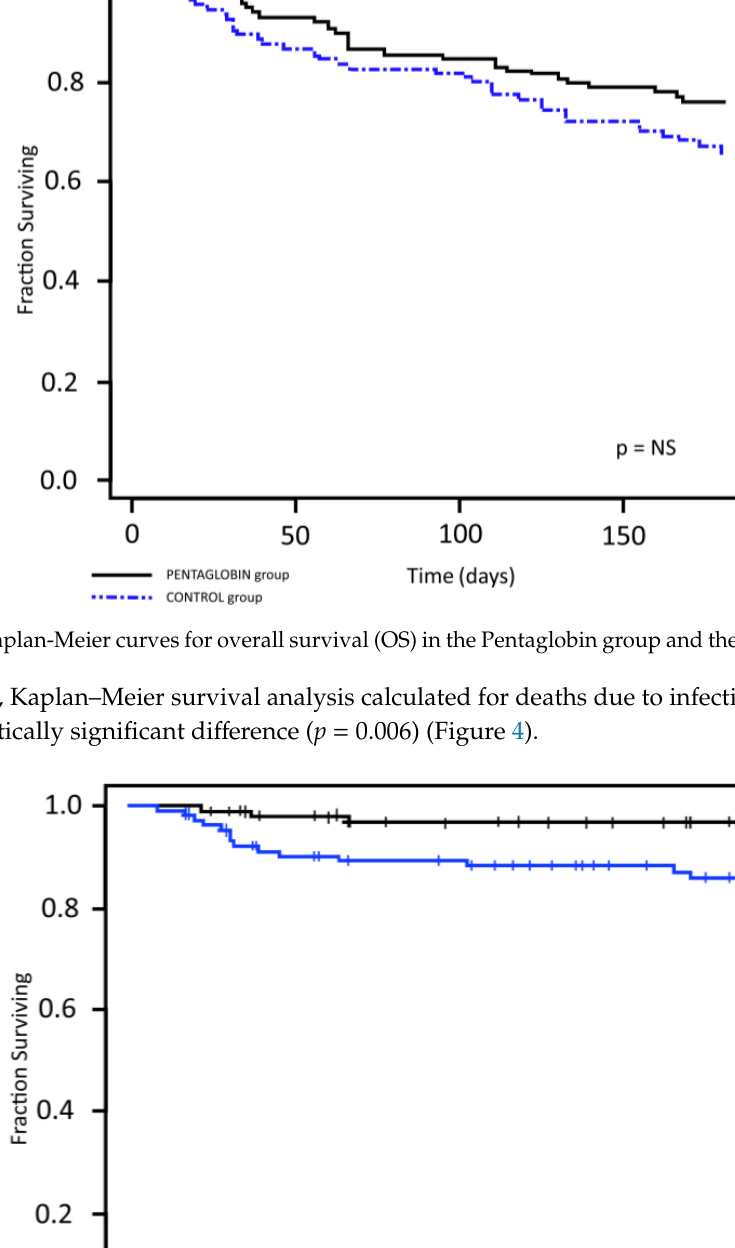
Figure 5. Kaplan–Meier survival curves in two groups calculated for deaths, excluding mucositis and enteritis. 3.3. Secondary Outcomes Box-plot analysis showed a statistically significant difference between the study groups for the number of days with body temperature both for ≥37.3 °C ( p < 0.001) and ≥38 °C ( p < 0.001 ) . Statistically significant differences between two study groups were found in the number of antibiotics used concurrently during the same infective episode ( p < 0.0001) and the number of changes of antibiotics because of the failure of treatment ( p < 0.0001). These box-plot analyses are displayed in Figure 6.